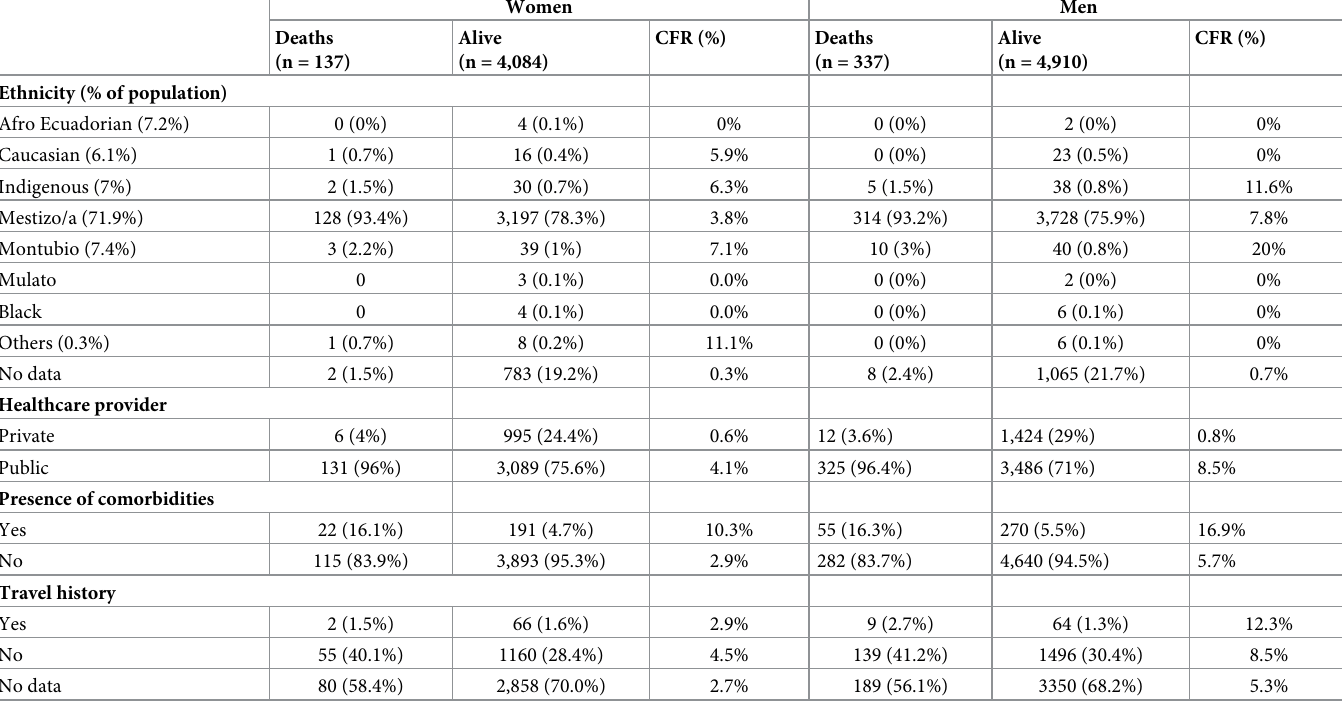
Table 2. Total number of deaths, patients alive and percentage of total (%) and case fatality rate (%) for women and men in different ethnic groups, type of health- care provision, presence of comorbidities and travel